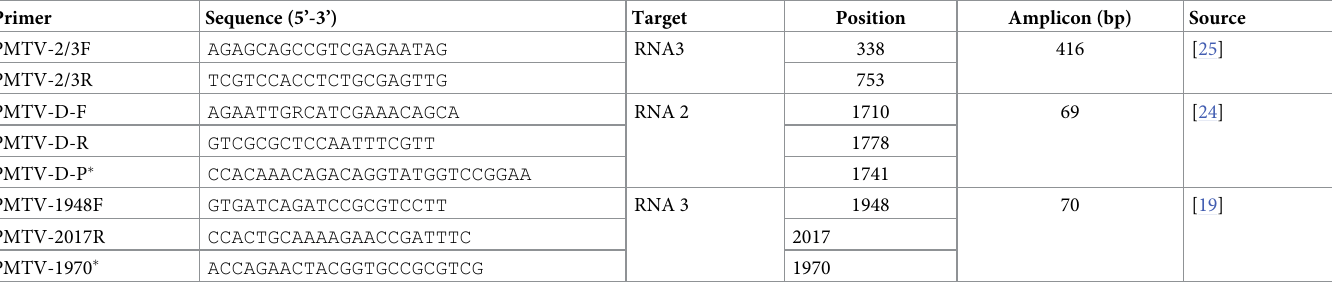
Table 1. PCR primers used for comparison analysis in the RPA assay for the detection of potato mop-top